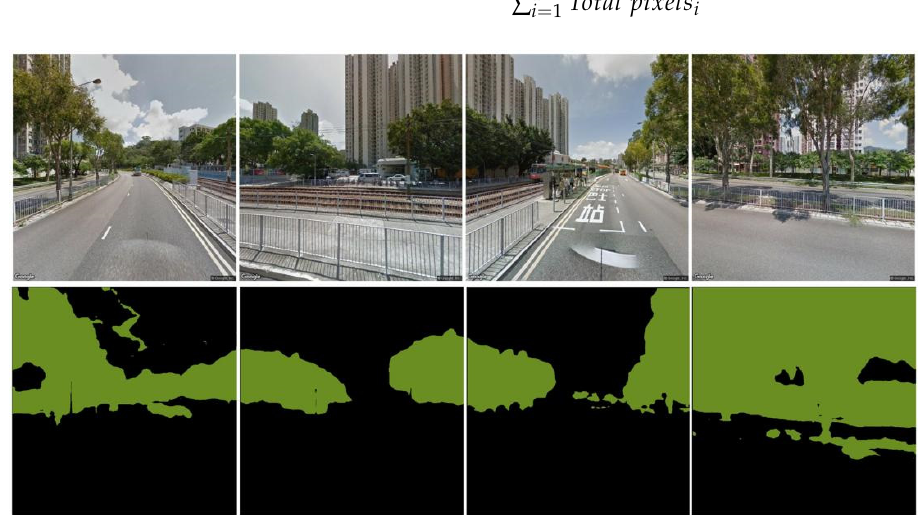
Figure 1. Machine learning technique–based estimation of the green view index.